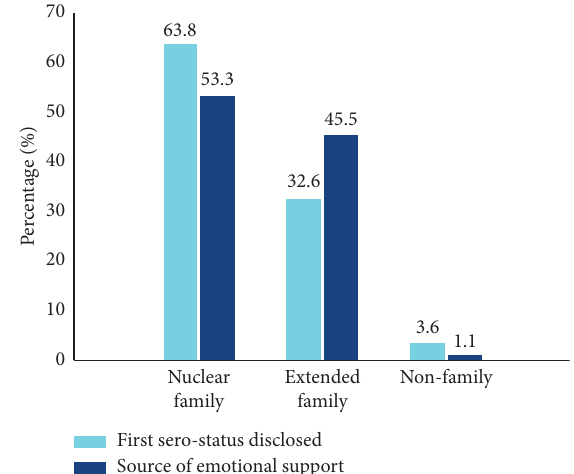
Figure 1: Disclosure recipient and source of emotional support.